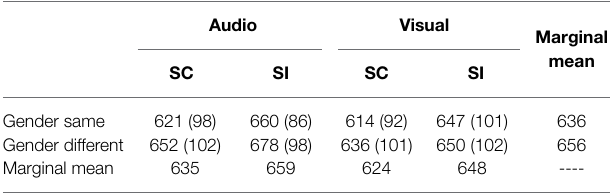
TABLE 1 | RTs across the gender and semantic conditions in two modalities across